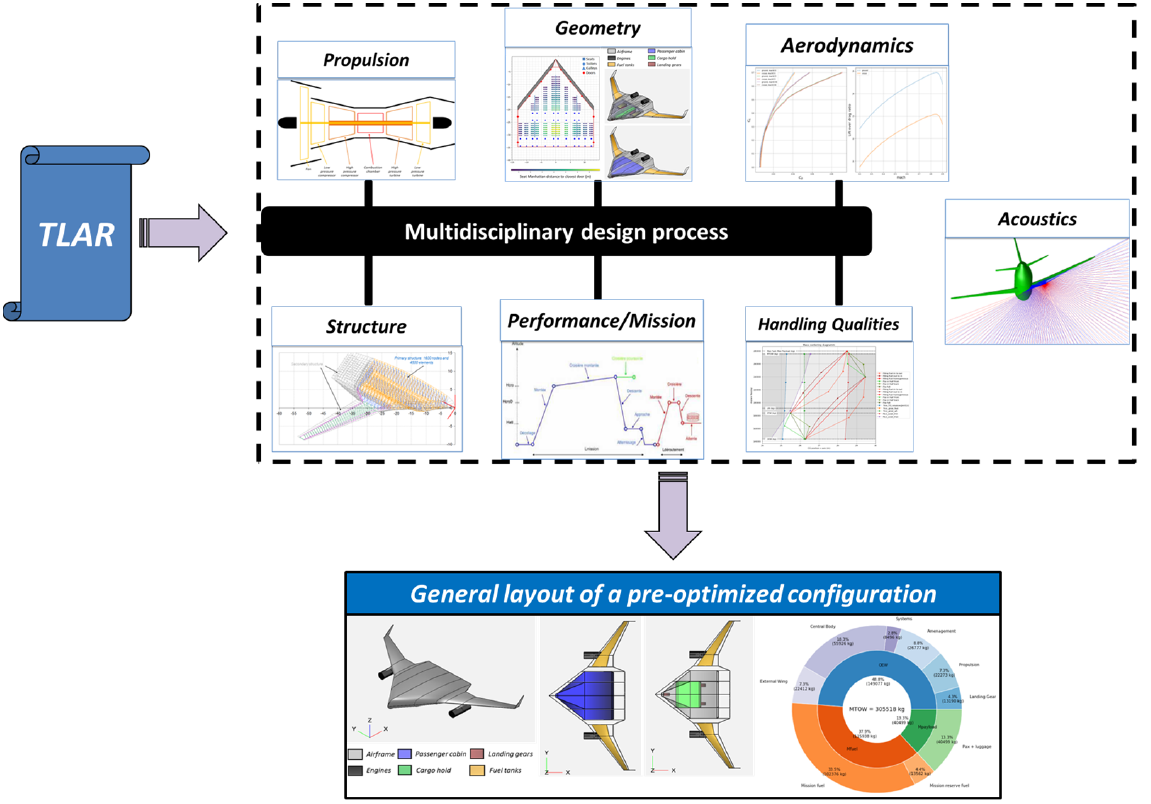
Figure 2. ONERA MDAO/OAD tool for BWB applications.